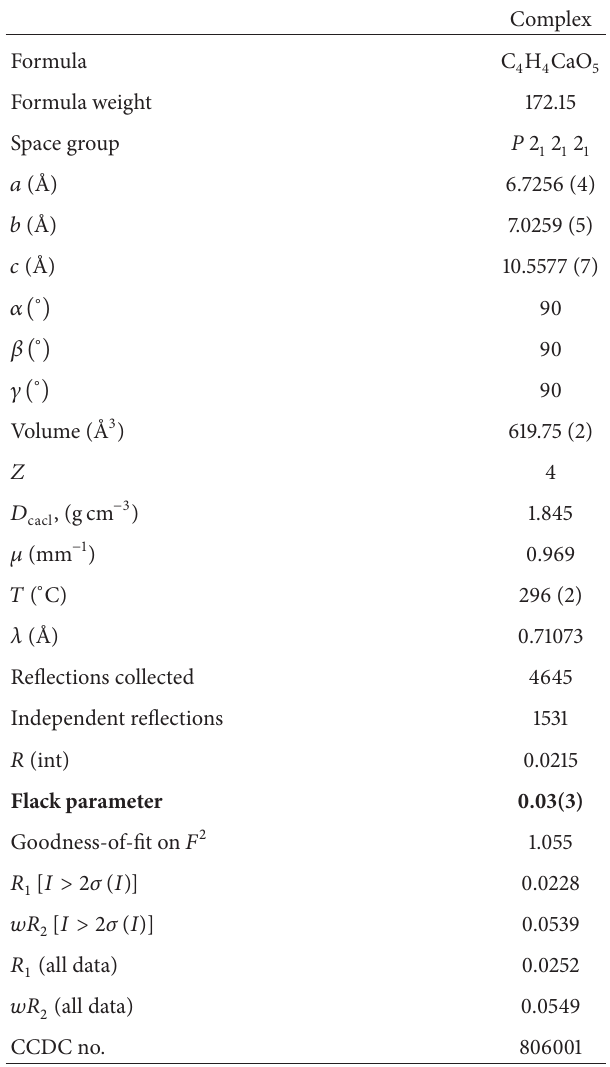
Table 1: Crystallographic data for the complex.